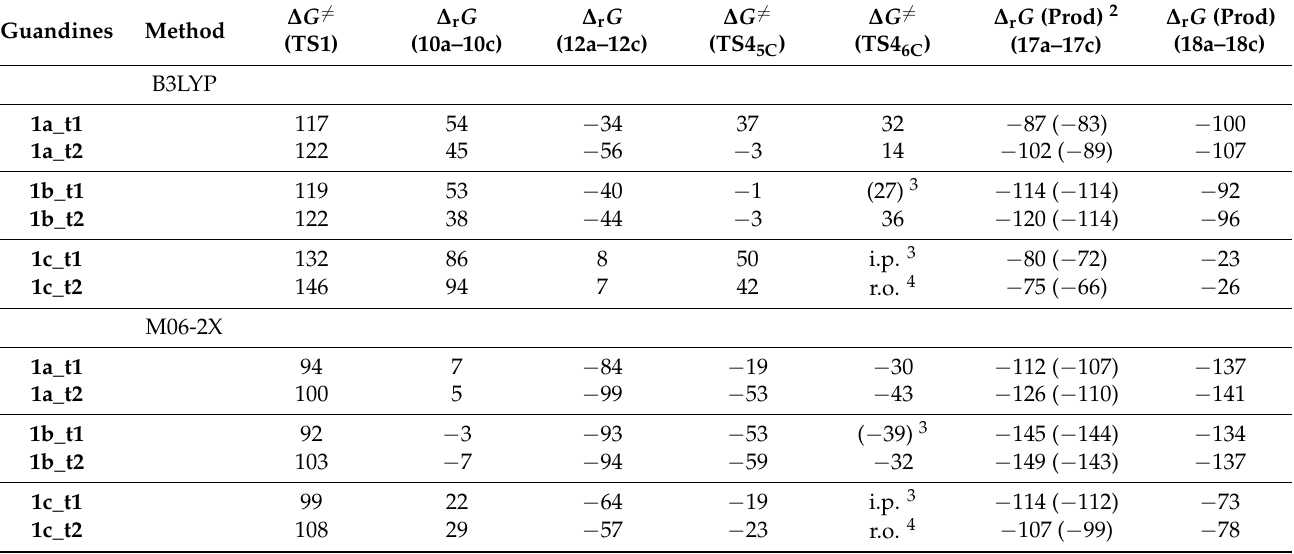
Table 1. The relative Gibbs energies calculated for the selected structures along the reaction paths 1 .